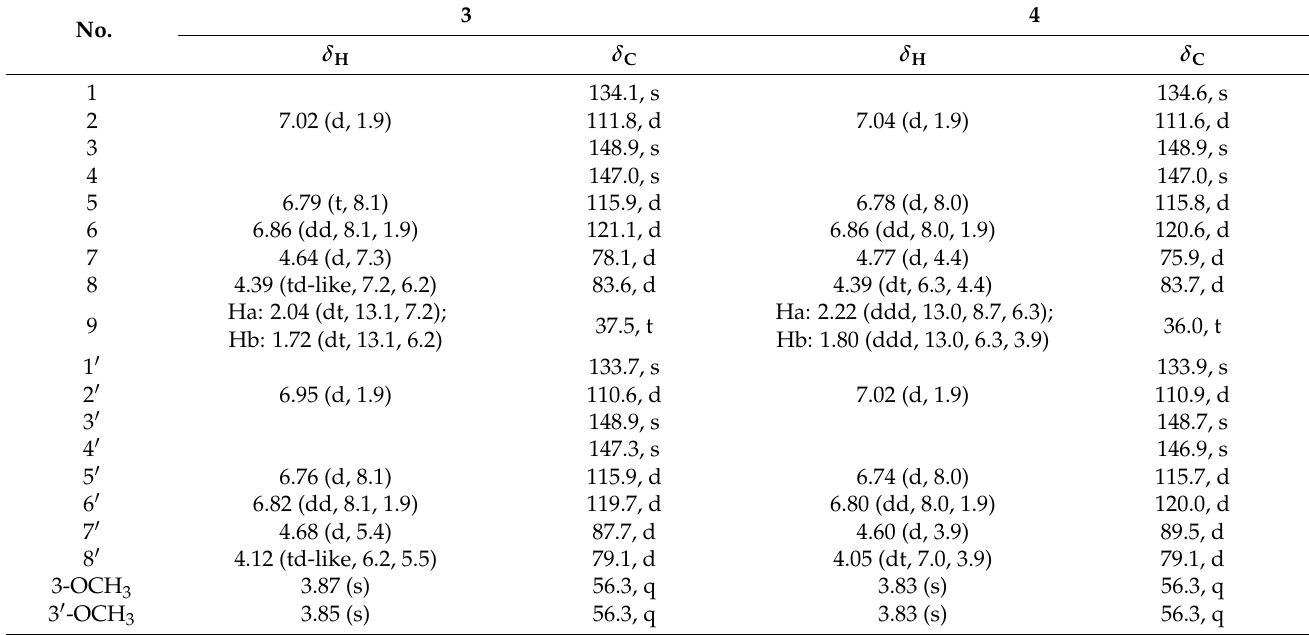
Table 2. 1 H (600 MHz) and 13 C (150 MHz) NMR data of 3 and 4 in MeOD ( δ in ppm, J in